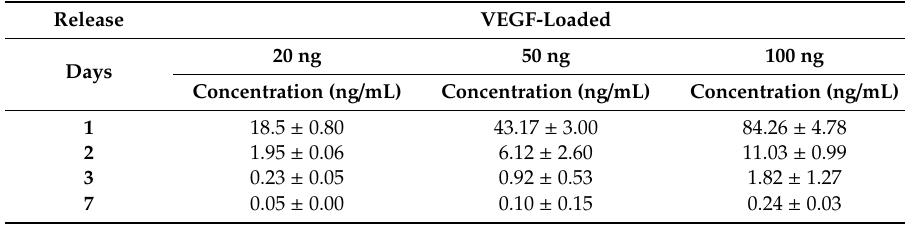
Table 1. Concentration of released VEGF within 7 days in ECM culture medium enriched with 0.1% FCS at 37 ◦